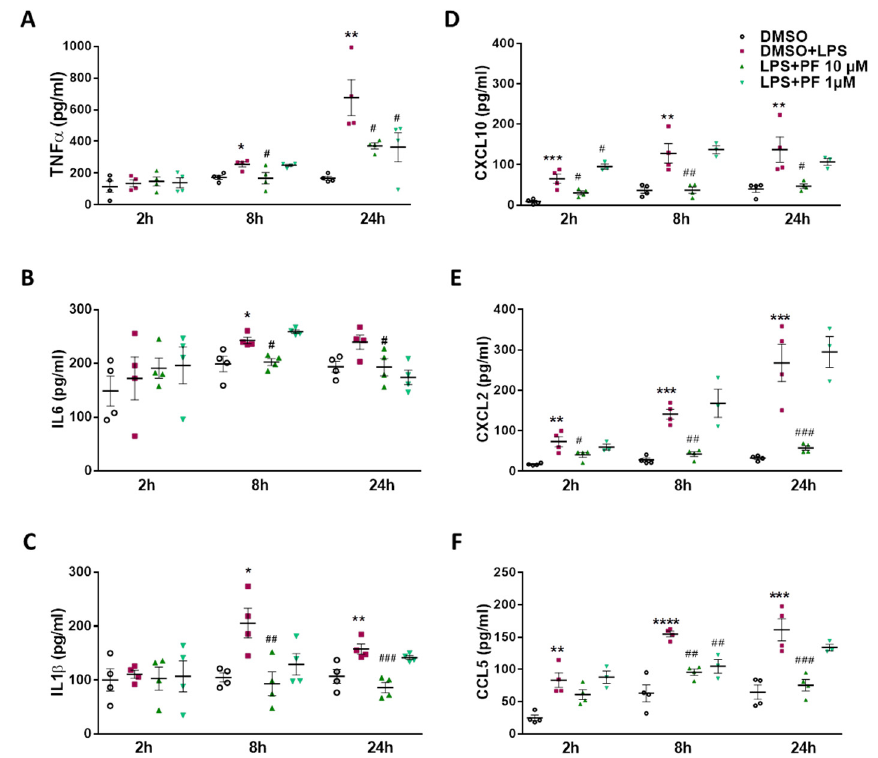
Figure 5. Inhibition of ATX by PF8380 attenuates LPS-induced secretion of cyto-/chemokines in BV-2 microglia. Cells were treated with DMSO control, LPS (20 ng/mL) plus DMSO in the absence or presence of PF8380 (‘PF’; 10 and 1 µM) for the indicated times. Supernatants were collected. ( A – F ) Concentration of cytokines TNF α , IL6, and IL-1 β and chemokines CXCL10, CXCL2, and CCL5 were quantified by ELISA. Values are expressed as mean ± SEM of three independent experiments. (* p < 0.05, ** p < 0.01, *** p < 0.001, **** p < 0.0001 compared to DMSO control; # p < 0.05, ## p < 0.01, ### p < 0.001 compared to LPS-treated cells; one-way ANOVA with Bonferroni correction).